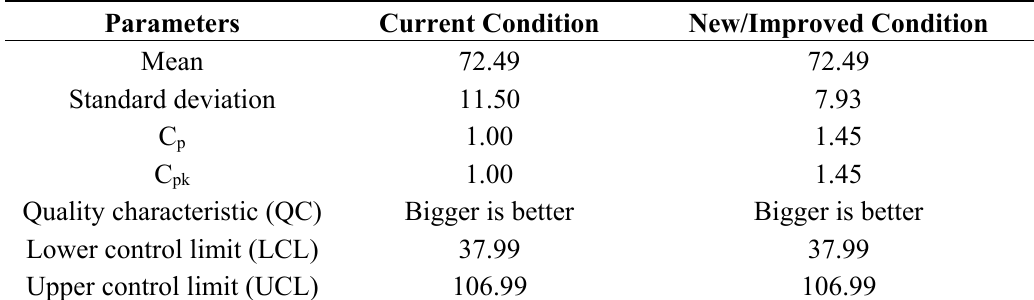
Table 5. Plotting parameters in the variation reduction